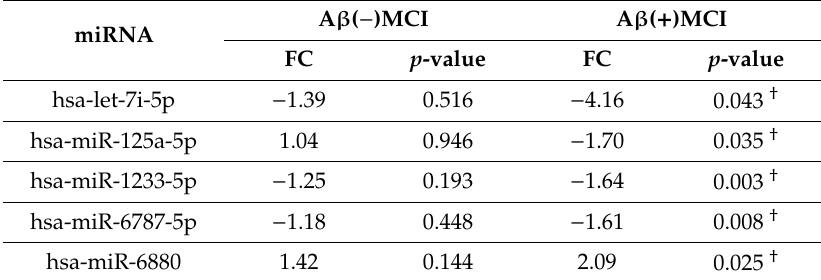
Table 2. Fold changes in the five most significantly detected miRNAs in the platelets from patients with A β ( − )MCI and A β ( + )MCI compared to those of the CNI group. A β ( − )MCI A β ( + )MCI miRNA FC p -value FC